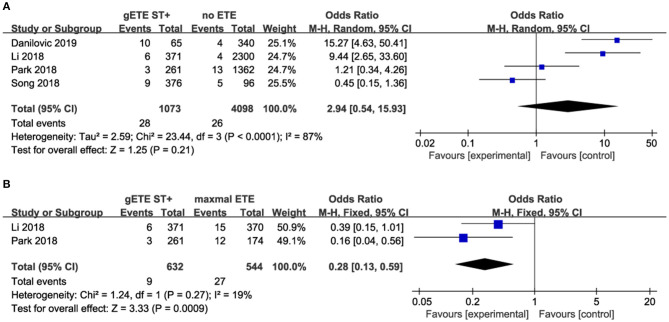
Forest plot for DM comparison between gETE st+ with (A) no ETE (B) maximal ETE.